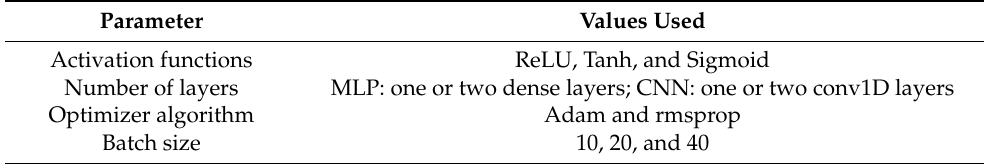
Table 4. Values used for each hyperparameter in this study. Parameter Values Used Activation functions ReLU, Tanh, and Sigmoid Number of layers MLP: one or two dense layers; CNN: one or two conv1D layers Optimizer algorithm Adam and rmsprop Batch size 10, 20, and